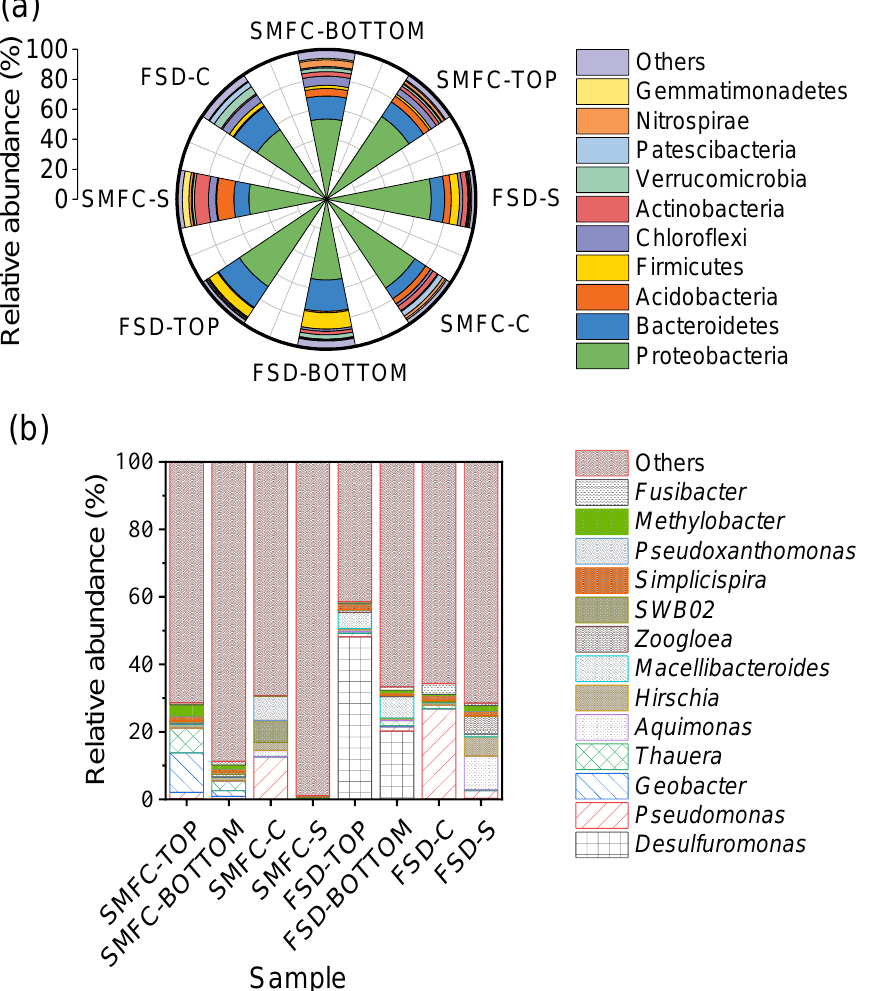
Figure 5. Taxonomic classification of dominant phyla ( a ) and genera ( b ) based on 16S rRNA sequences of anode biofilms, cathode biofilms, and soil samples from different reactors. The “others” represents the dominant genera with a relative abundance of < 1%.